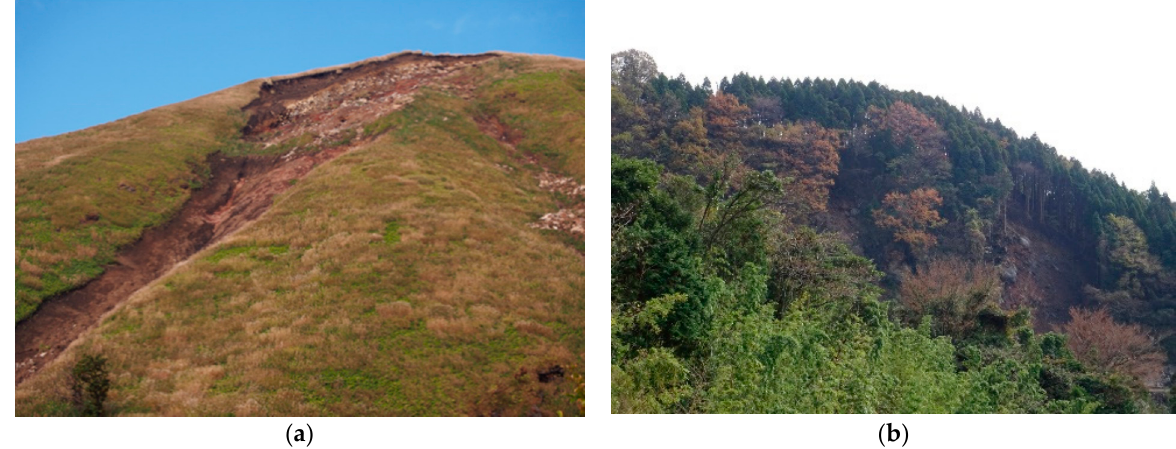
Figure 6. Photos of landslides at rock mass ( a ) Landslides occurred on andesitic rock slope ( b ) Landslides occurred on andesitic rock slopes. The outcrop was partially covered with trees.